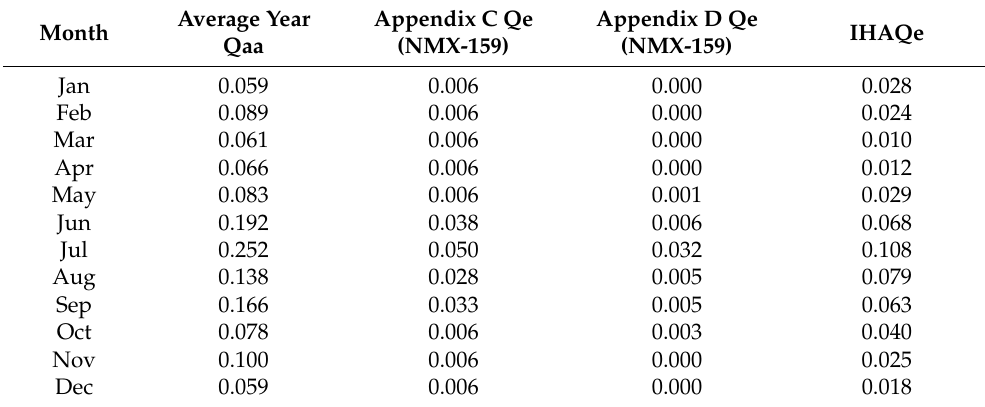
Table 6. Comparative table of environmental flows (m 3 /s). Qaa = Average annual flow; Qe = Environmental flow.